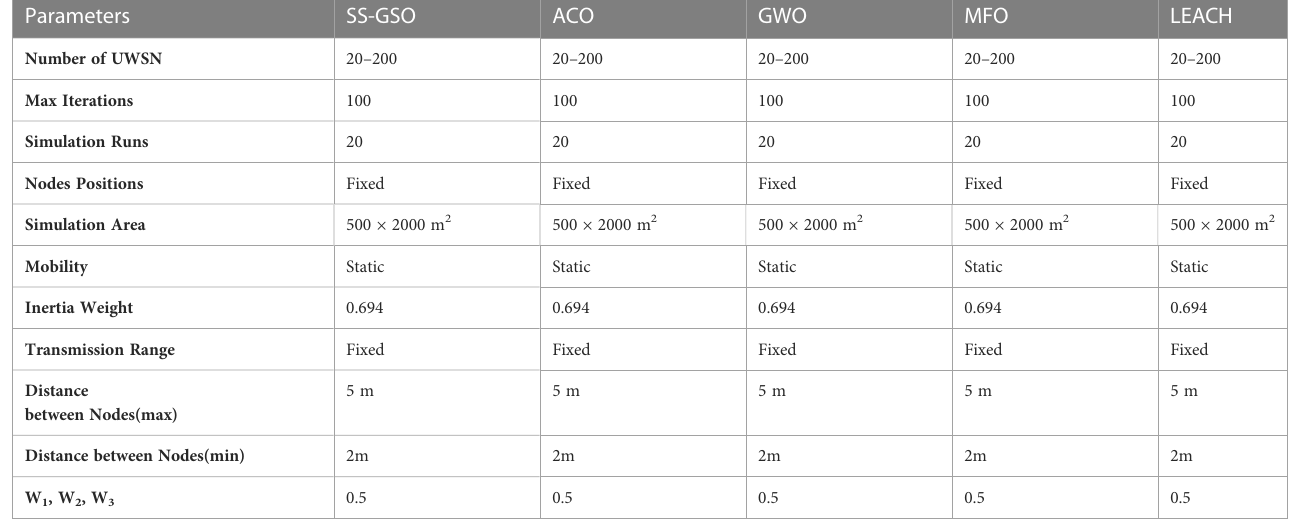
TABLE 2 Simulation